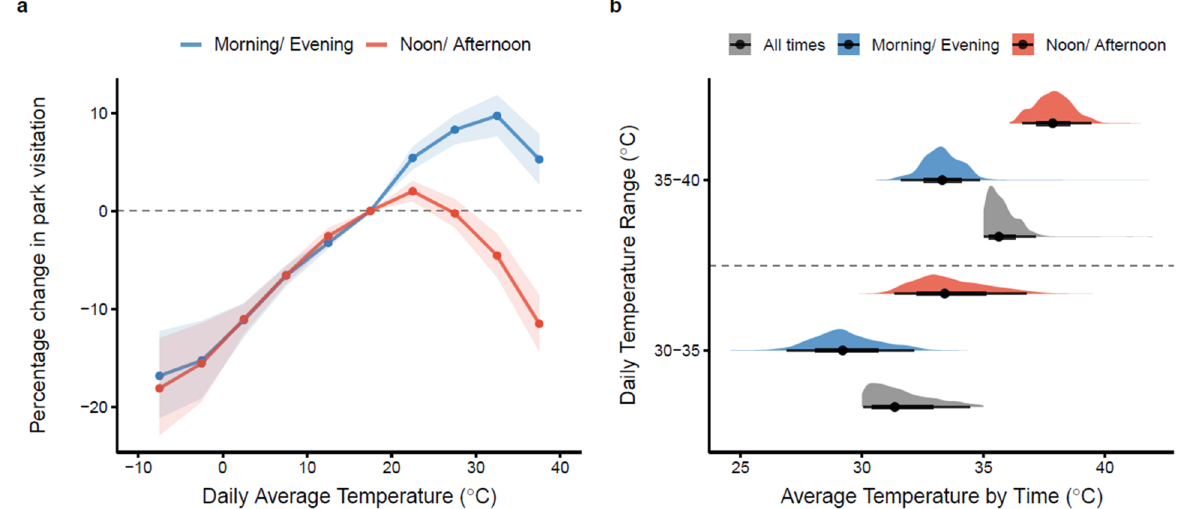
Figure 3. Activity and temperature distribution in hot and cool times of a day. ( a ) Effects of the daily average temperature on activities at different periods of the day. Shaded areas are 95% confidence intervals. Density plots display the distribution of temperatures for each sub-sample. (b ) Average daytime temperature for different periods. Temperature distribution on days with the daily average temperature in 30–35 °C and 35–40 °C bins are presented, respectively. The point in each distribution is the median. The thicker and thinner lines show the interquartile range (i.e., 25–75%) and 95% confidence intervals. The colored shades display the density